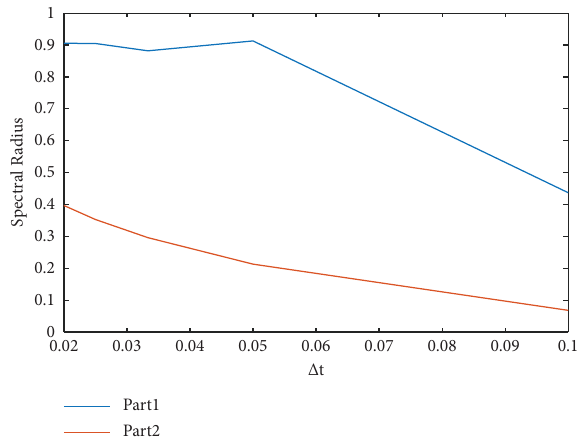
Figure 4: Stability plot of example 3 for diferent values of Δ t